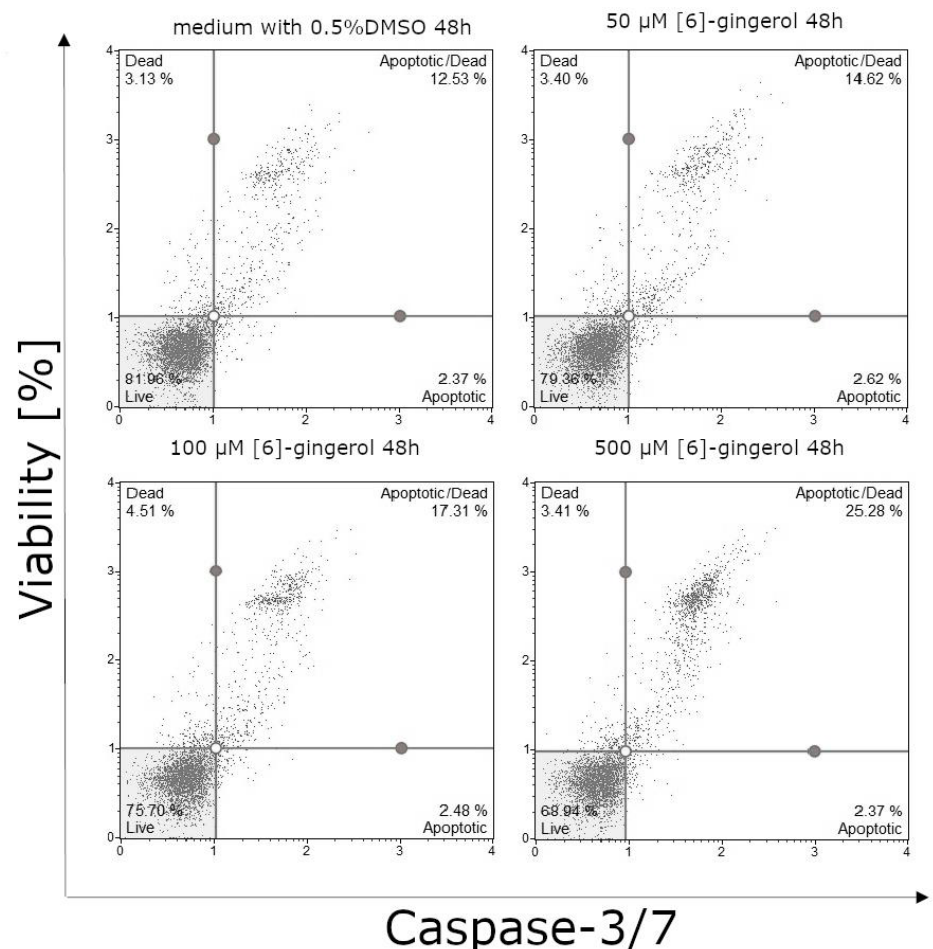
Figure 9. [6]-gingerol induce apoptosis in the U-118MG cells. Cells were treated with DMSO or various concentration of [6]-gingerol for 48 h. Adherent cells were collected and stained with Muse TM Caspase-3 / 7 Reagent and 7-AAD and events for live cells were counted with the Muse Cell